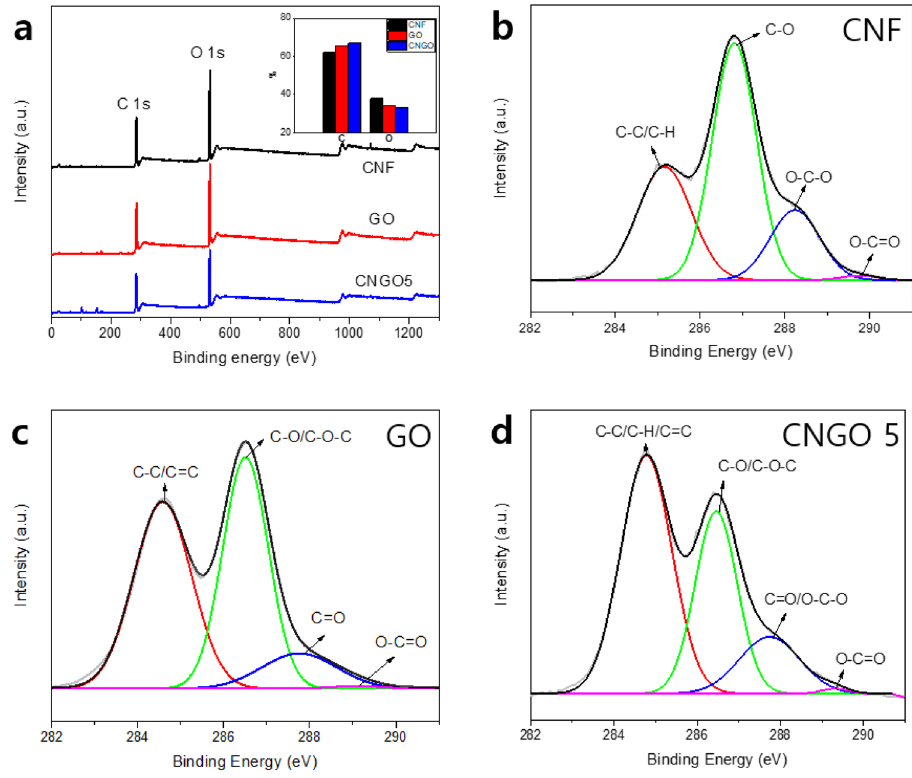
Figure 5. XPS results of the pristine CNF, GO, and CNGO 5: ( a ) XPS survey spectra, ( b ) C 1 s spectra of the pristine CNF, ( c ) C 1 s spectra of GO, and ( d ) C 1 s spectra of CNGO 5.